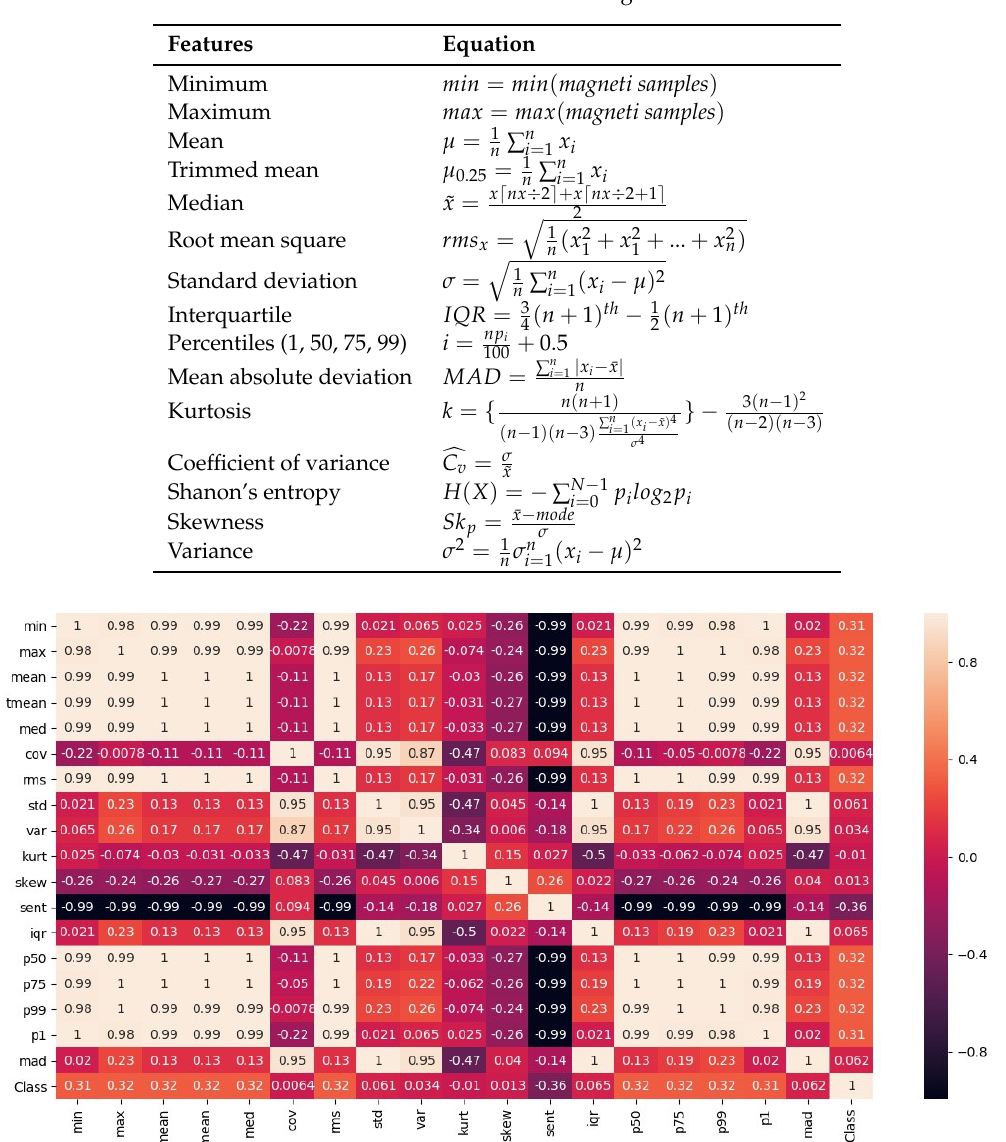
Figure 3. Correlation of selected features to predict a specific class. ’Class’ weight in rows shows the importance of